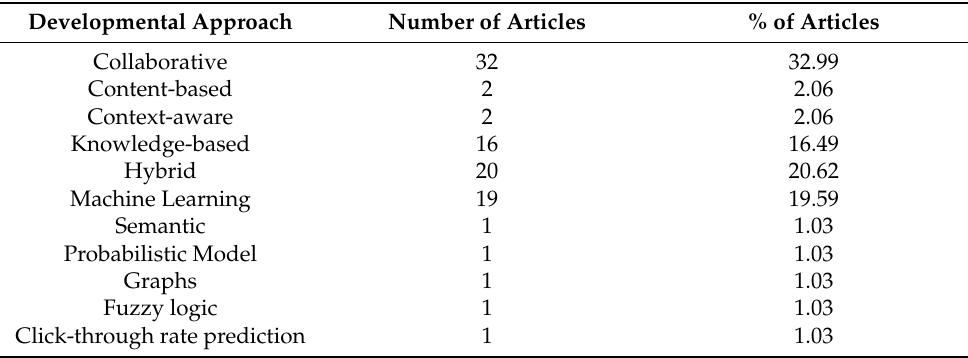
Table 8. Percentage number of articles according to developmental approach.